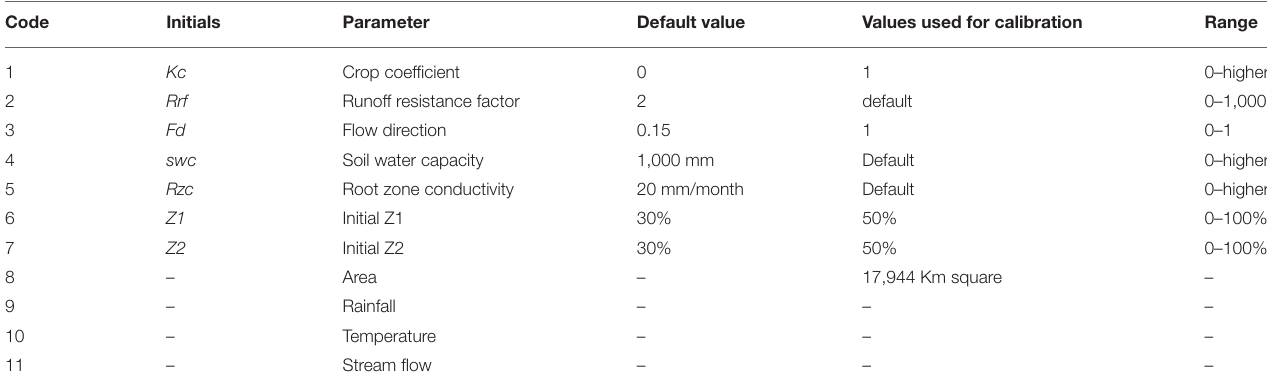
TABLE 2 | Calibration parameters adopted for modeling the stream